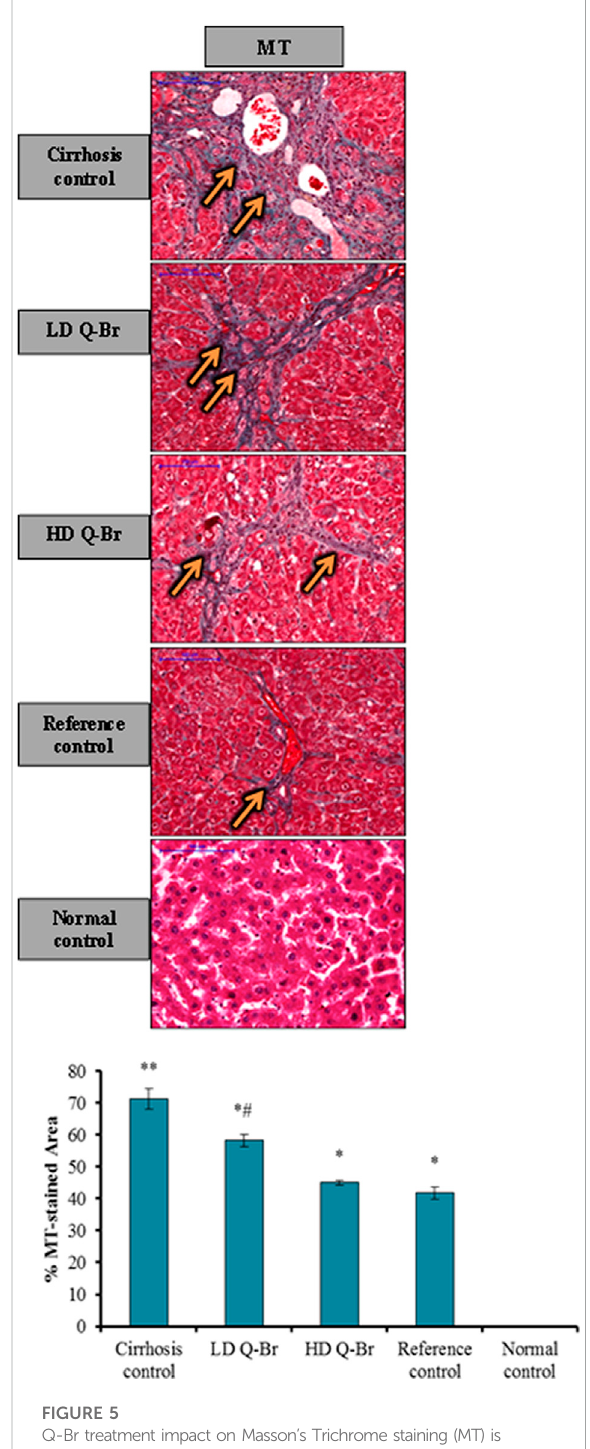
FIGURE 5 Q-Br treatment impact on Masson ’ s Trichrome staining (MT) is showingintensivegreenstainingofcollagen fi bers(orangearrow)inthe cirrhosis control group. Considerable reduction of MT staining from LD Q-Br to HD Q-Br and Silymarin-treated livers, respectively. Scale bar indicates 100 µm magni fi cations. The quantitative analysis of MT staining of liver tissue sections is diagrammed below the images. All the dataareexpressedasMean±SD, n =3and p issigni fi cantlyconsidered atvalue ≤ 0.05.** p < 0.05vs.normalgroup;* p < 0.05vs.cirrhosiscontrol group;and # p < 0.05vs.Silymarin-treatedgroup.Immunohistochemistry of fi brotic and extracellular matrix